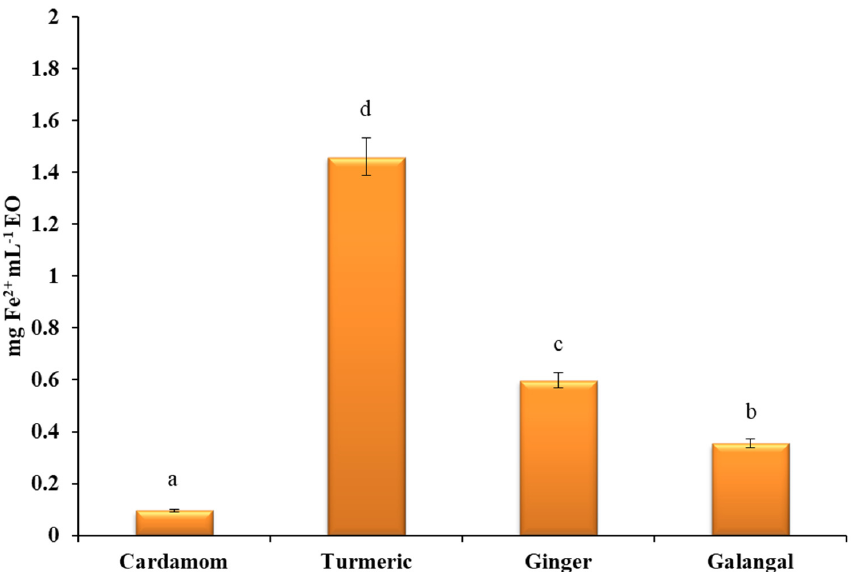
Figure 4. Antioxidant activity of EOs expressed as mg Fe 2+ ion equivalents per milliliter of essential oil (mg Fe 2+ mL − 1 EO). All measurements were performed in duplicate. For comparison of the mean values, one-way ANOVA followed by S-N-K post hoc were applied. A different superscript letters (a, b, c, d) indicate a statistical difference in AA of evaluated EOs ( p < 0.05).